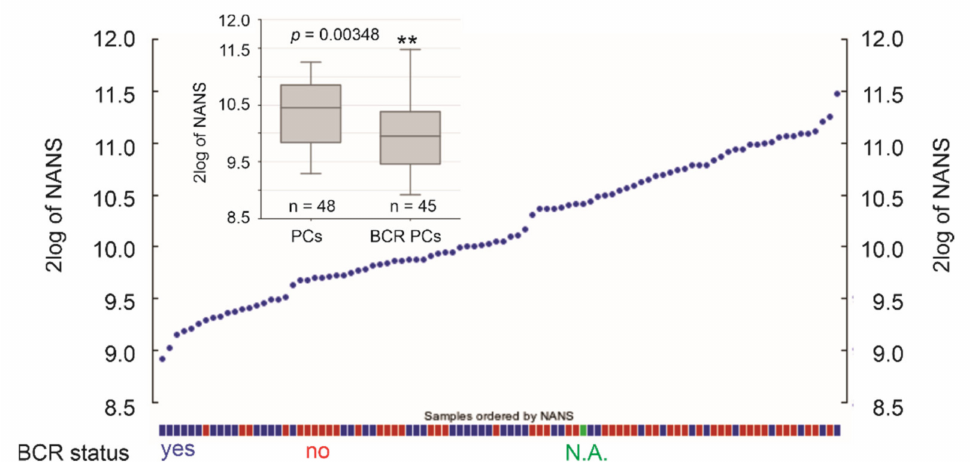
Figure 9. Downregulation of NANS expression in primary PCs with BCR development. NANS mRNA expression in individual PCs within the Sueltman dataset are shown; the status of PC with and without BCR development is indicated. The illustrations were produced using the R2: Genomics platform. ** p <